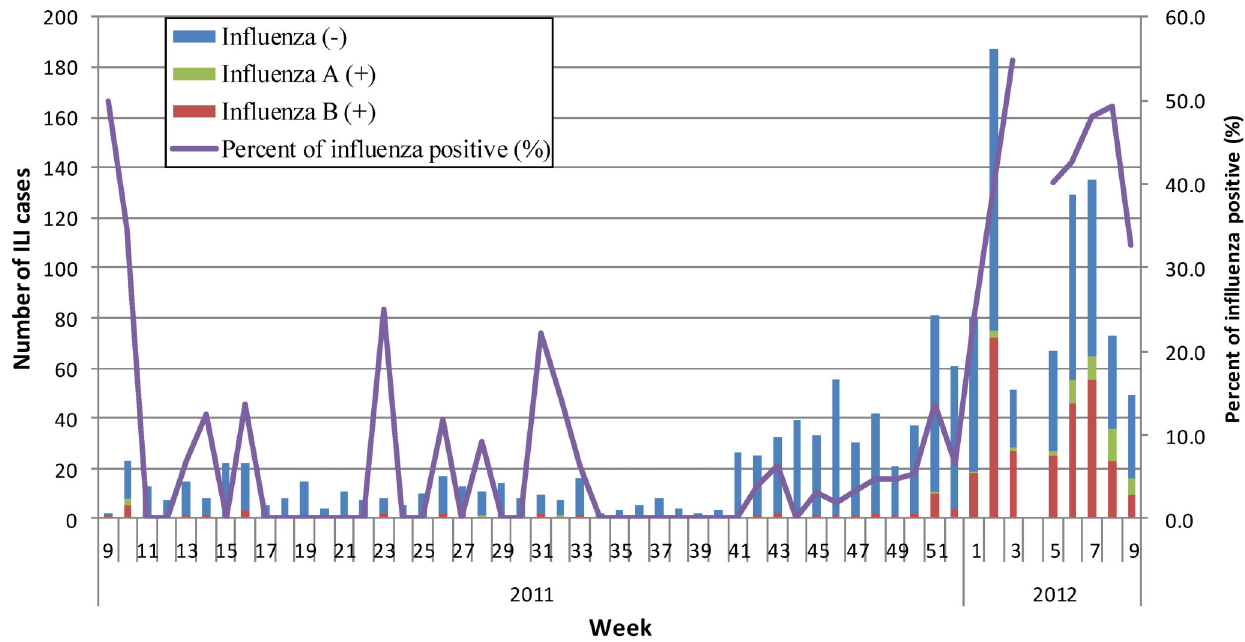
Figure 2. Distribution of enrolled influenza-like illness (ILI) cases and laboratory confirmed influenza cases in Soochow University Affiliated Children’s Hospital (SCH) between March 2011 and February 2012. Note: No specimens were collected during week 4 of 2012 due to the Spring Festival; the subtype for all influenza A viruses was seasonal H3.